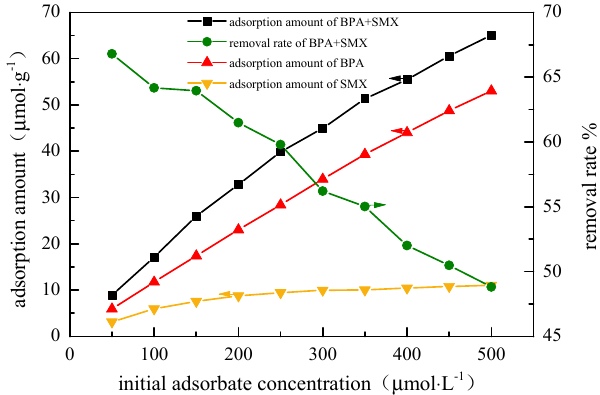
Figure 5. E ff ect of initial concentration of solution on adsorption performance. Figure 5. Effect of initial concentration of solution on adsorption performance.